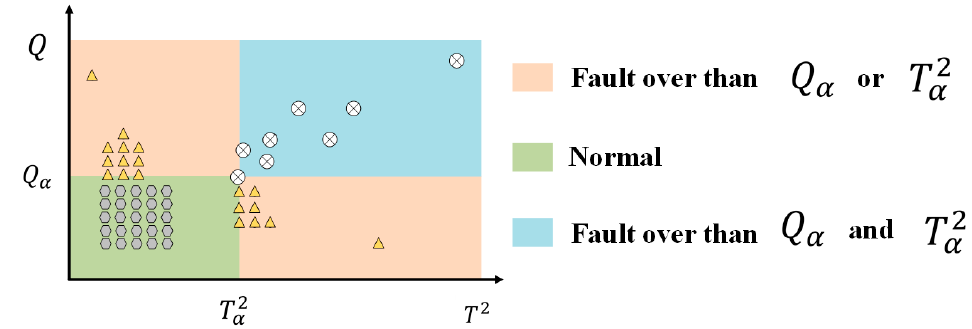
Figure 3. A geometric interpretation for fault detection using two statistics. If some sudden abnormal deviations occur on the variables, such as a mismatch between the actual variable and base variable, the T 2 statistic is able to detect such